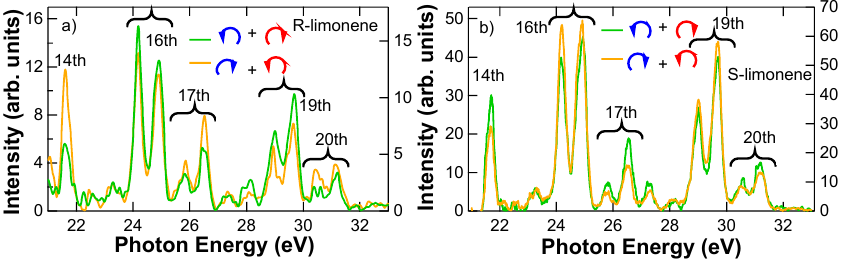
Fig. 1 . Experimental setup for the observation of the spectra of CP-HHG. MAZEL-TOV is the optical scheme to generate two-color counterrorating circularly polarized laser field.